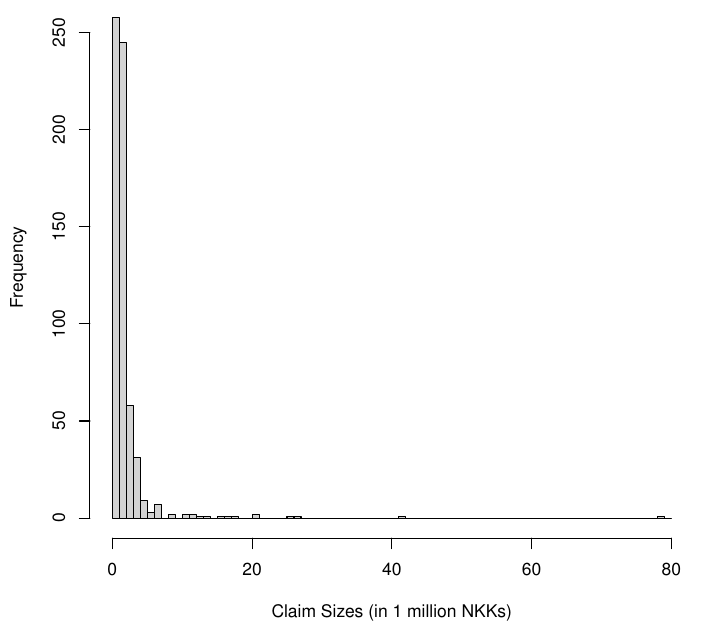
Figure 6. Histogram of Norwegian fire insurance data for 1990. Table 4. Summary statistics for Norwegian fire insurance claims, during 1990 (in 1 million NOKs). Sample Size Mean SD Minimum